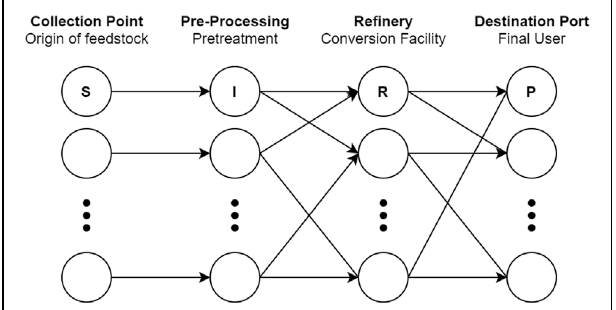
FIGURE 1 | Visual representation of supply chain